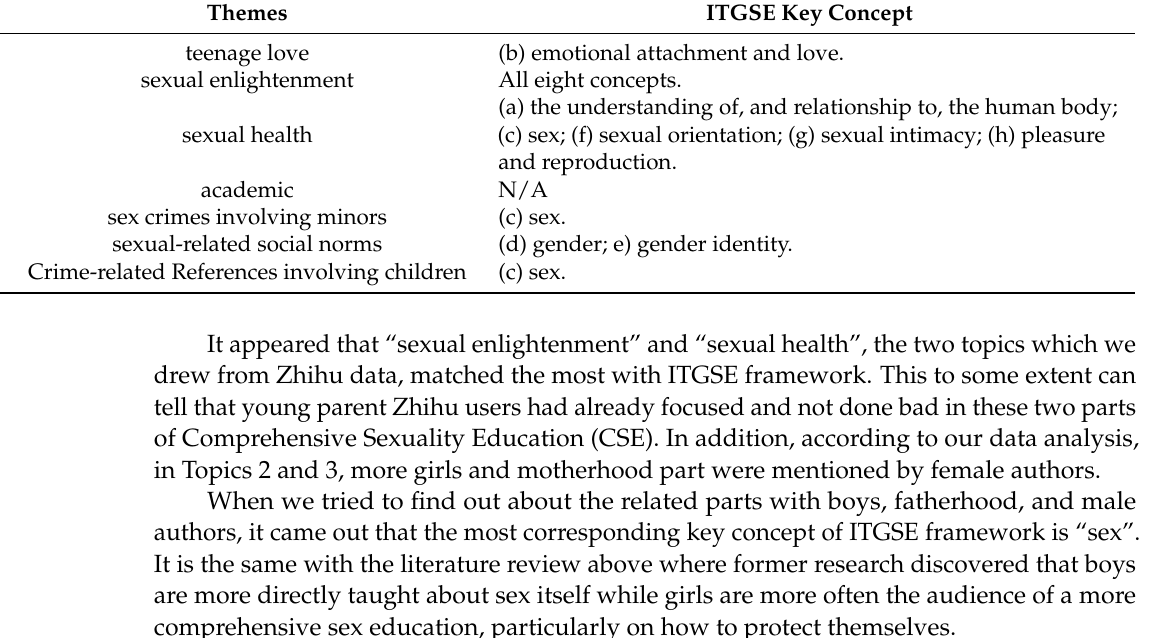
Table 3. Correspondence between ITGSE framework and themes produced by the STM model.